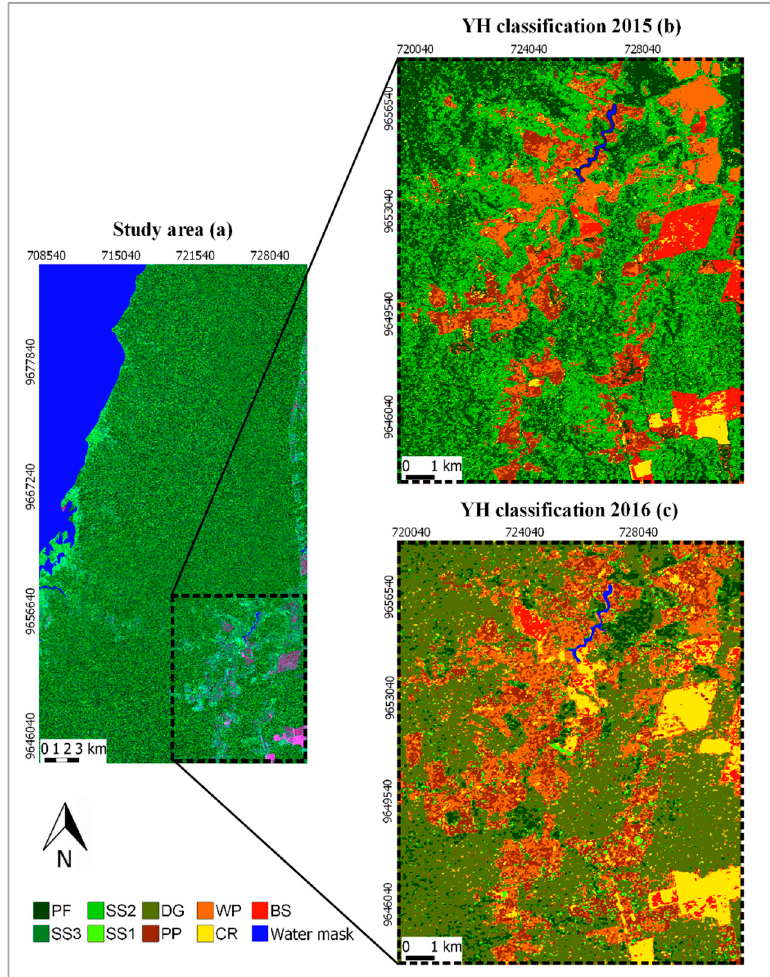
Figure 11. Location of the study area in the Tapajós National Forest. The image corresponds to the RGB color composite of HH / HV, VV / VH, and HH / VV ratios of ALOS / PALSAR-2 images mosaic ( a ). Black rectangle represents the land use, land cover, and forest degradation classification subsets of the study area from 2015 ( b ) and 2016 ( c ), based on Yamaguchi (YH) decomposition. For LULC class identification, see Table 1.